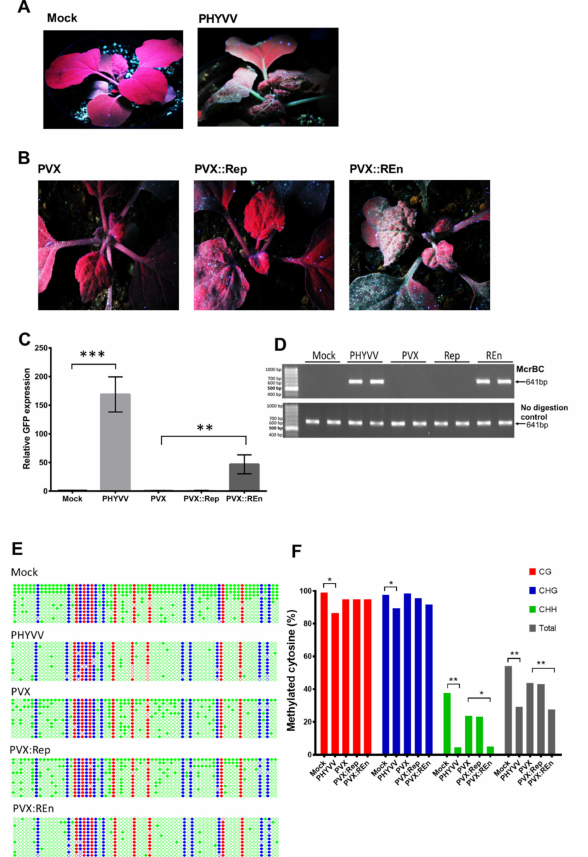
Figure 6. Transcriptional gene silencing (TGS) suppressor silencing analysis. ( A ) Nicotiana benthamiana 16c-TGS plants were inoculated by a biolistic procedure with PHYVV dimeric clones. Inoculated